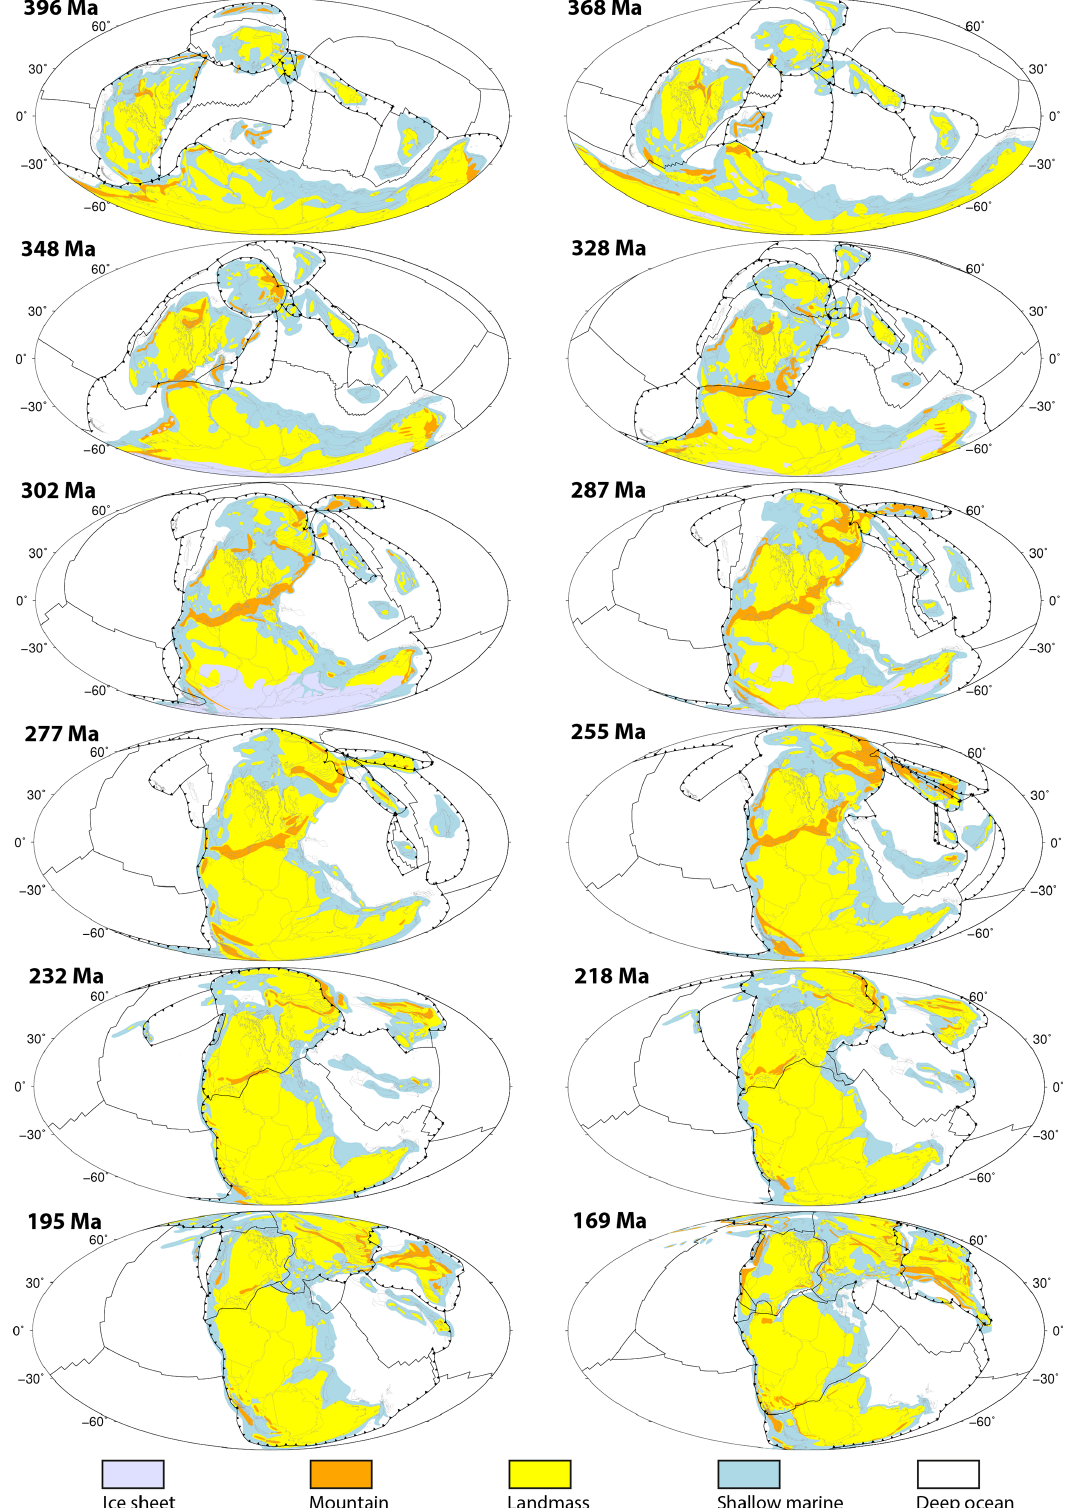
Figure 7. Global paleogeography from 402 to 2Ma reconstructed using the plate motion model of Matthews et al. (2016) and revised using paleoenvironmental data from the PBDB. Black dotted lines indicate subduction zones, and other black lines denote mid-ocean ridges and transforms. Grey outlines delineate reconstructed present-day coastlines and terranes. Mollweide projection with 0 ◦ E central